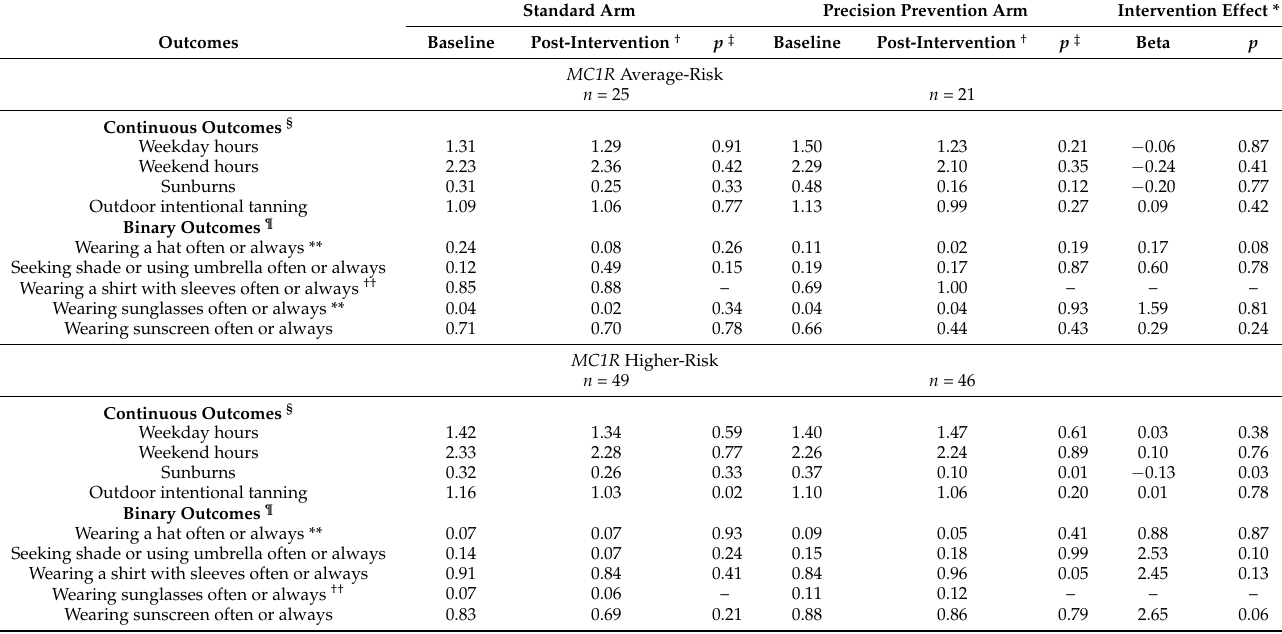
Table 5. Primary prevention outcome measures among children of participants at baseline and post-intervention and intervention effects by the parent’s MC1R risk